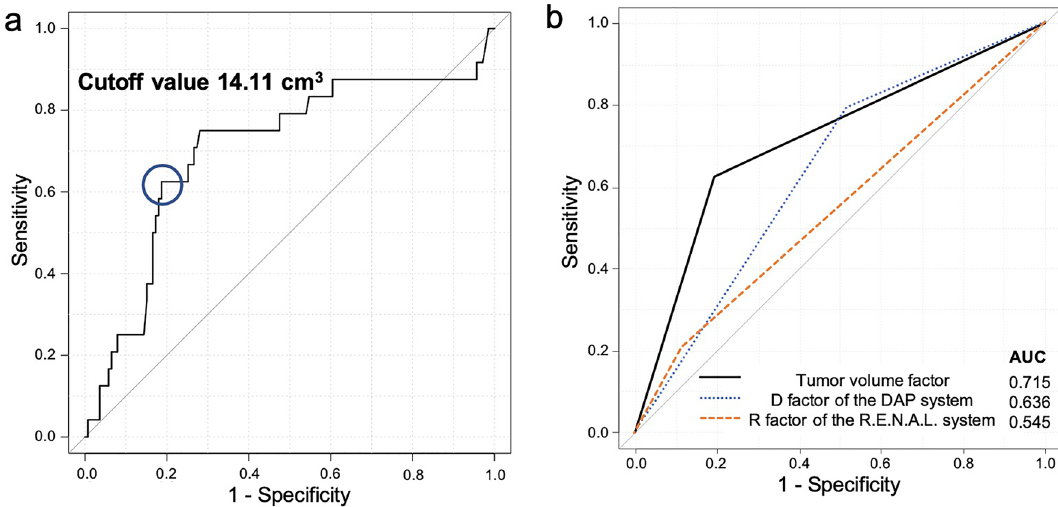
Figure 1. ( a ) Receiver operating characteristic curve of tumor volume and cutoff value for predicting eGFR reduction of ≥ 20%. ( b ) Comparison of the AUC values of the tumor volume (cutoff value ≥ 14.11 cm 3 ), D factor of the DAP system, and R factor of the R.E.N.A.L. system for predicting eGFR reduction of ≥ 20%. AUC area under the receiver operating characteristic curve; DAP diameter-axial-polar; R.E.N.A.L. radius, exophytic/ endophytic, nearness to collecting system or sinus, anterior/posterior, and location relative to polar lines.